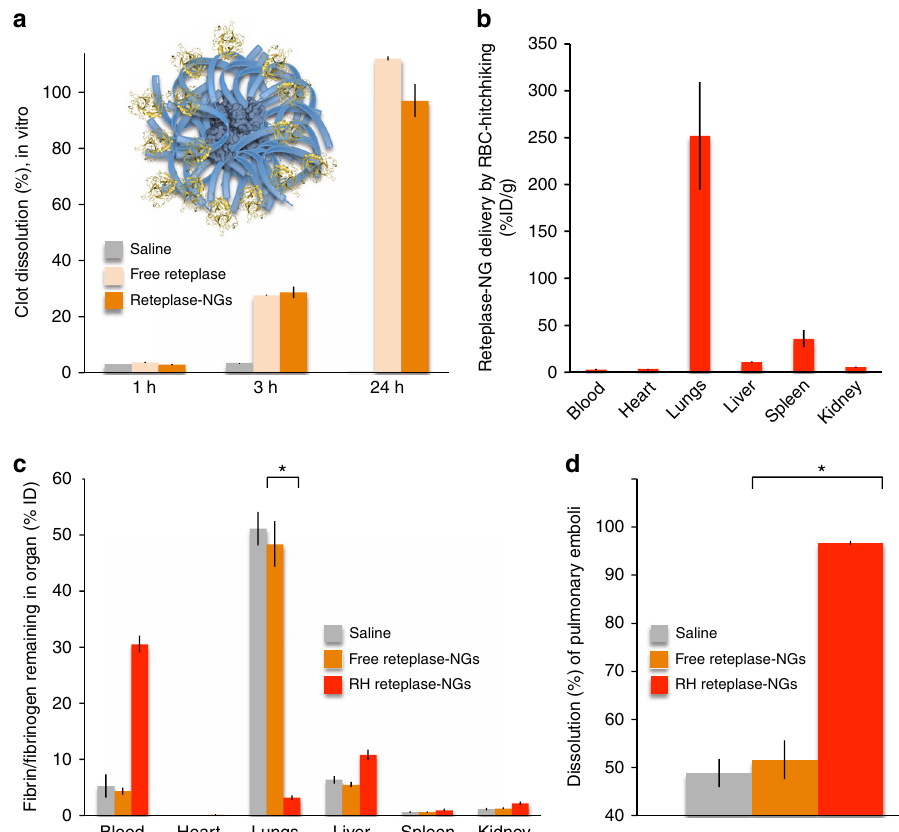
Fig. 6 RH effectively delivers therapeutic cargo to ameliorate a model of pulmonary embolism. a Inset, schematic of nanogels (NGs) with thrombolytic enzyme reteplase (gold) conjugated to the dextran (blue) shell. The bar graph shows the degree to which reteplase-NGs, free reteplase, or saline dissolve preformed fi brin clots in vitro. Reteplase conditions contained 4 nM of reteplase, with reteplase concentration in reteplase-NGs quanti fi ed by reteplase-NG coupling ef fi ciency. b Biodistribution of RH reteplase-NGs at 1 h after injection, showing high lung uptake. c All mice were intravenously injected with ~1 – 5 micron diameter fi brin clot emboli (I-125-labeled). Mice were also treated with either saline, free reteplase-NGs, or RH reteplase-NGs at 12 micrograms reteplase per mouse. The amount of I-125-labeled fi brin/ fi brinogen remaining in each organ at 1 h post injection is quanti fi ed. d Degree to which initially injected emboli were cleared from the lungs. For all plots in this fi gure, each data point represents mean ± s.e.m ( n = 4). * P < 0.001, non-paired, two-tailed